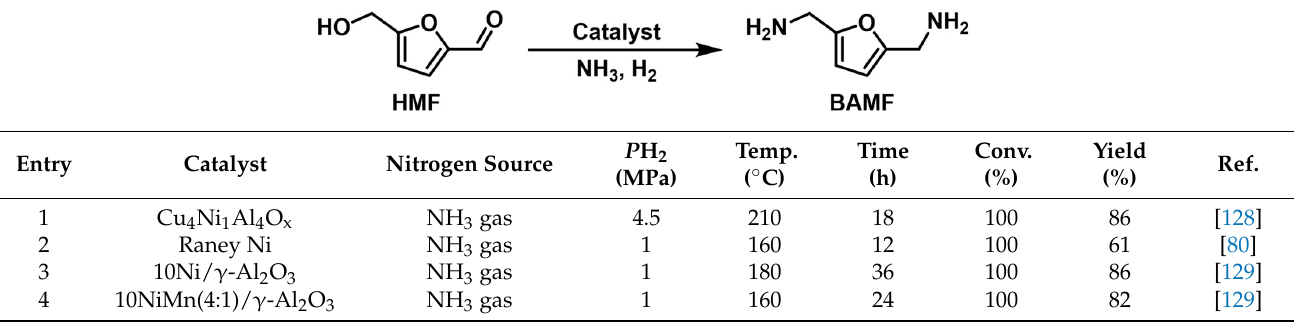
Table 9. Direct amination of HMF with NH 3 to synthesize BAMF.